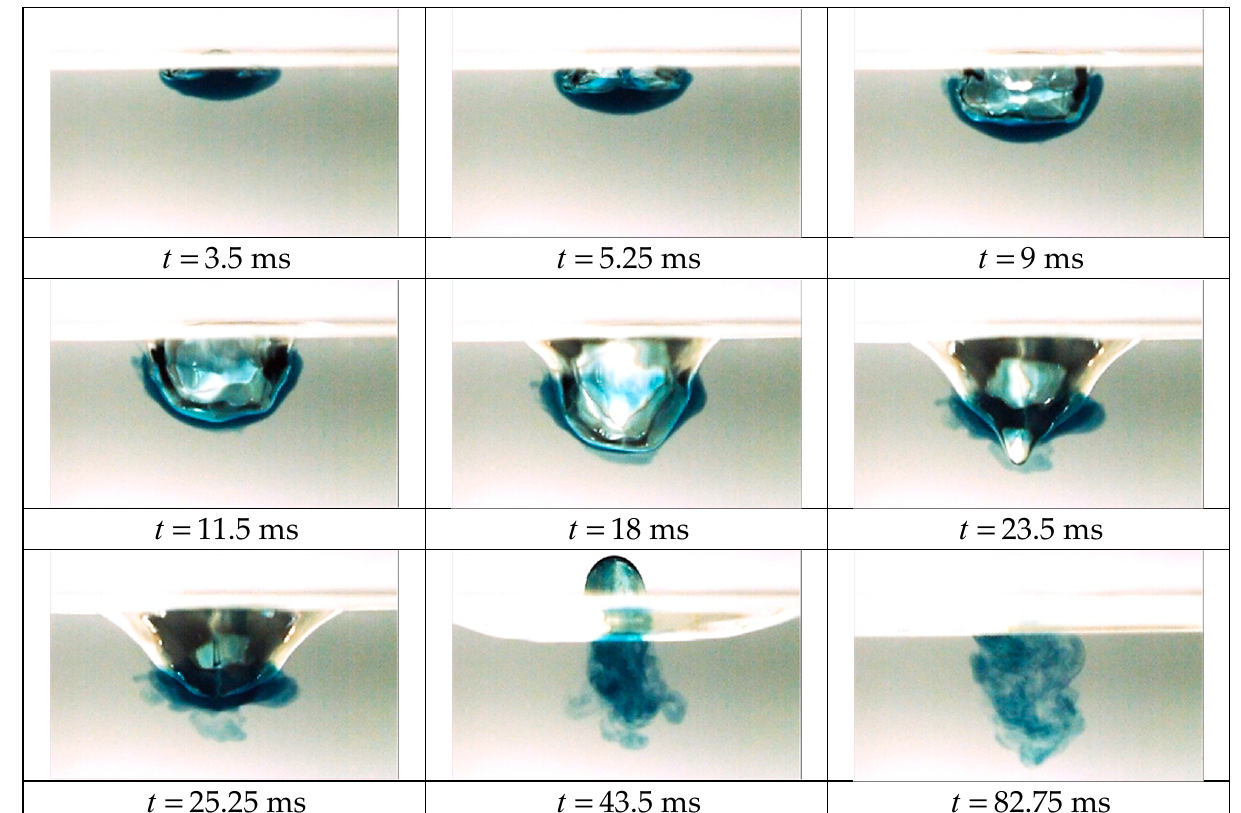
Figure 7. Side view of the flow evolution pattern in the transitional mode (drop of an diluted aqueous ink solution 1:800, ρ = 1 g/cm 3 , σ = 73 g/s 2 , µ = 0.01 g/cm · s is immersed in tap water: D = 4.3 mm, U = 1.0 m/s, E σ = 4.2 µ J, E k = 20.8 µ J, Re = 4300, Fr = 24, We = 60, Bo =